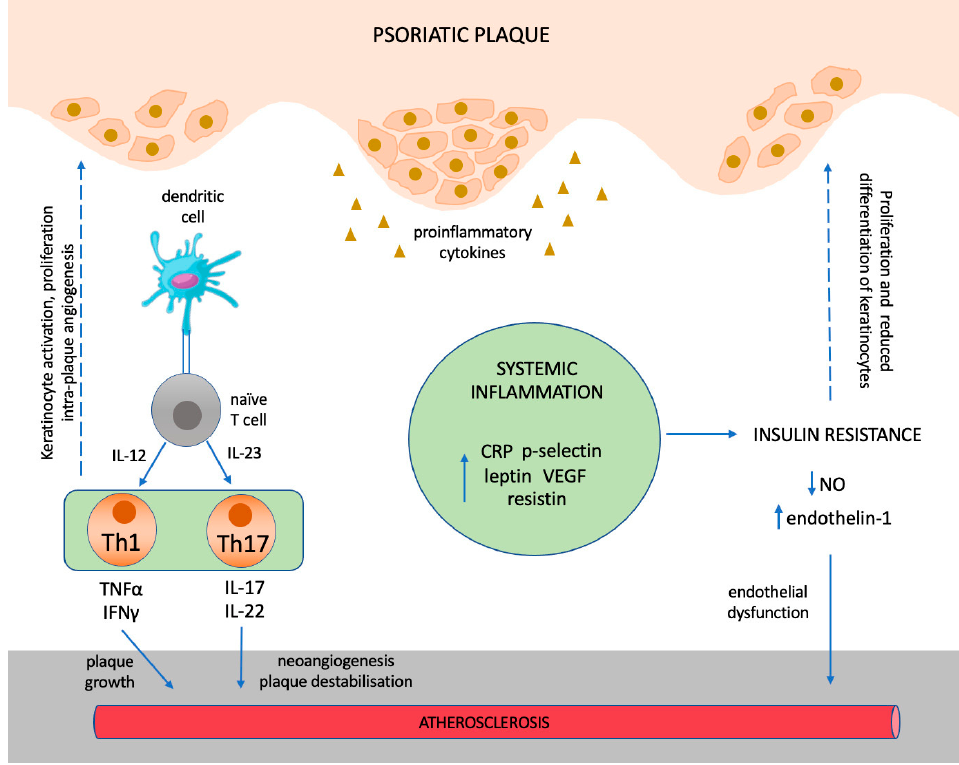
Figure 2. Shared immunologic mechanisms between psoriasis and atherosclerosis.